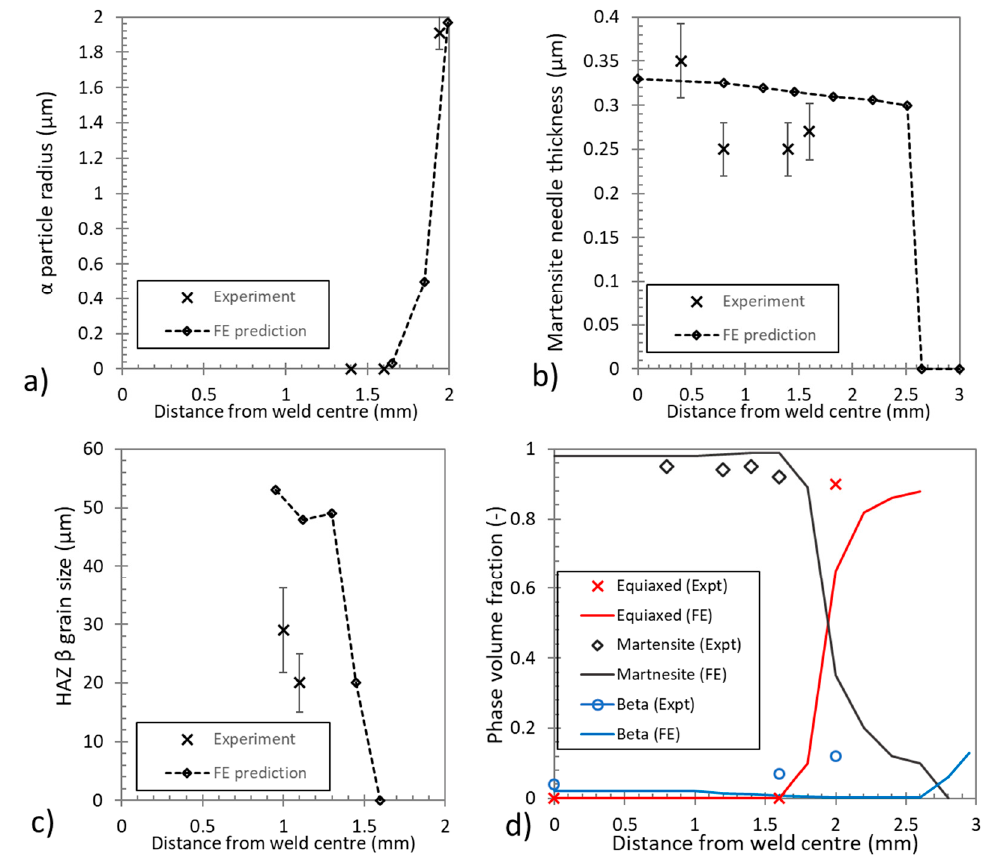
Figure 13. FE–metallurgy coupled model predictions for weld a: ( a ) α radius; ( b ) martensite needle thickness; ( c ) β grain size in the HAZ; ( d ) phase volume fractions.